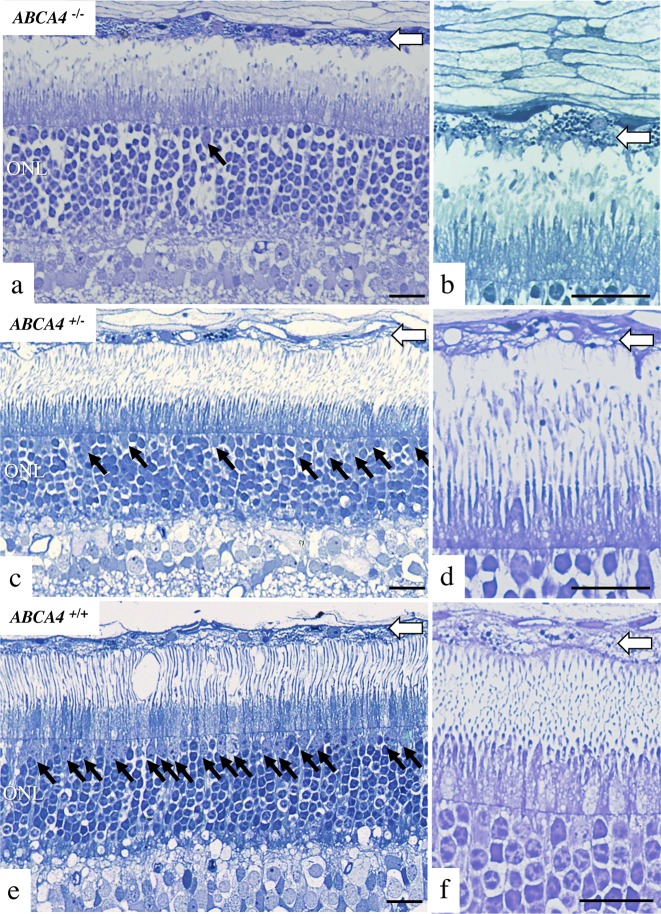
Histopathology.Light microscopic histology of a 12-year-old affected (LAB4) dog (A, B), 12-year old heterozygote (LAB6) dog (C, D) and 10-year old unaffected (German spaniel) dog (E, F) taken at comparable locations in the superior central retina (0.5–1.5 cm dorsal to the optic nerve on the sagittal plane). Cone photoreceptors in the retina of the affected dog (A) were scarce (cone nuclei indicated with black arrow) compared with the retinas of the heterozygote (C) and wild-type (E) dogs. In the affected dog (B), accumulation of lipofuscin was abundant in retinal epithelial cells (thick white arrow), compared to heterozygote (D) and wild-type (F) dogs. Photoreceptor outer segment disruption is artifactual. All scale bars = 20 microns; ONL = outer nuclear layer.